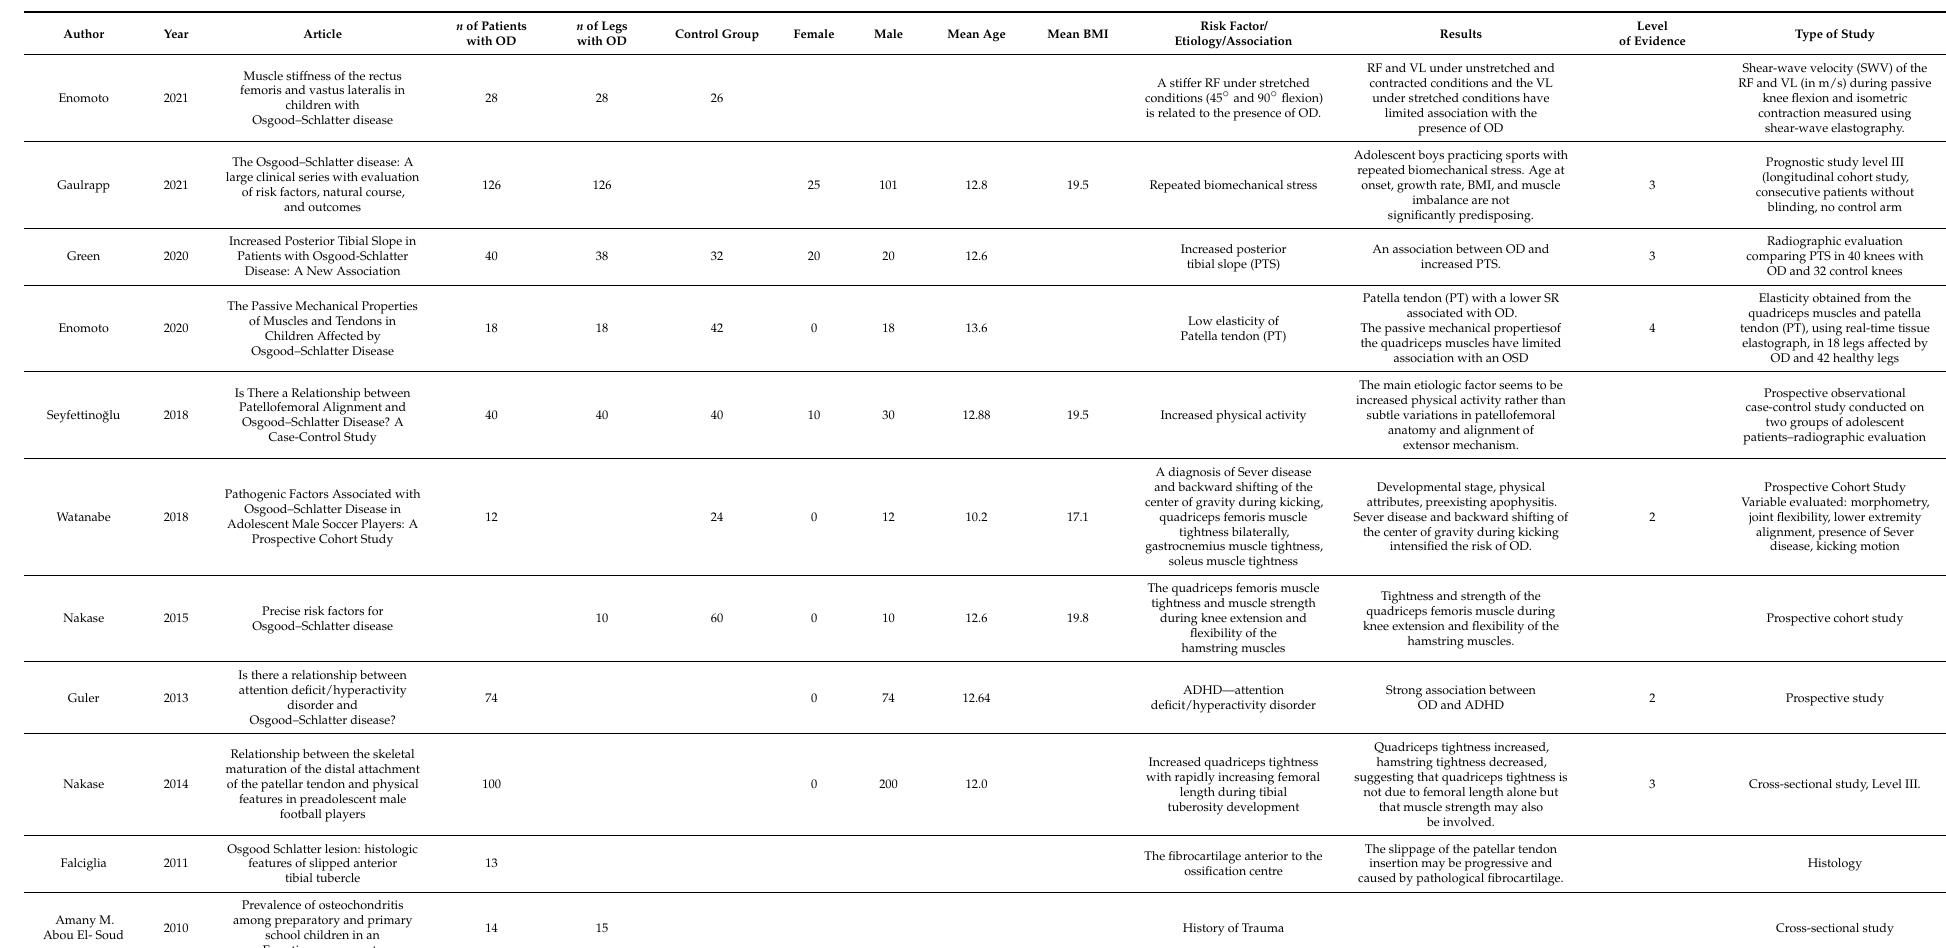
Table 1. Studies of risk factors associated to